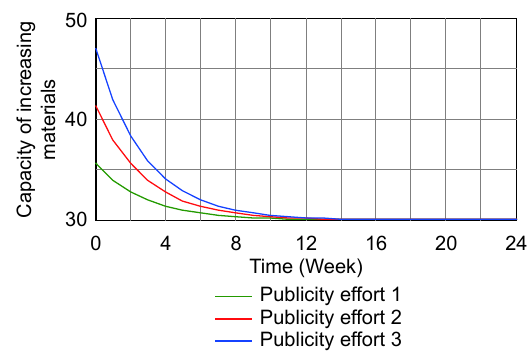
Fig. 10 Comparison of the government’s ability to collect and transfer materials under different publicity